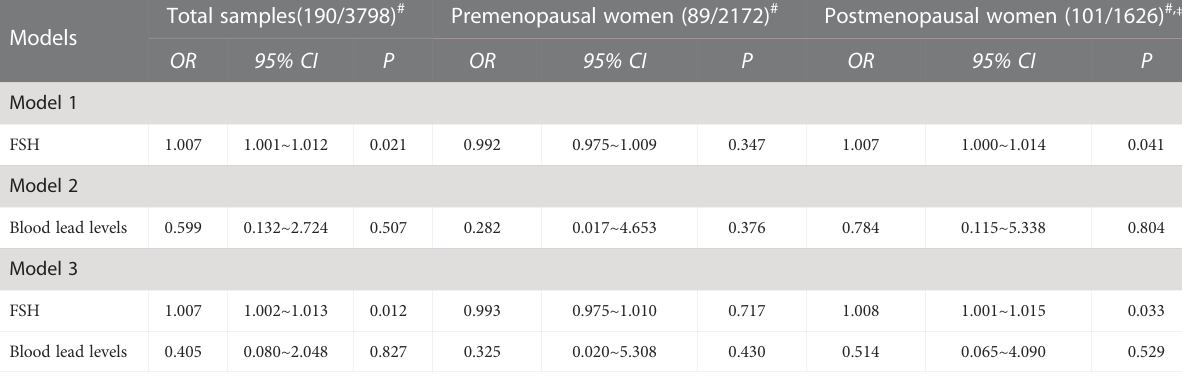
TABLE 4 The associations of FSH and blood lead levels with the risk of fractures ※ .